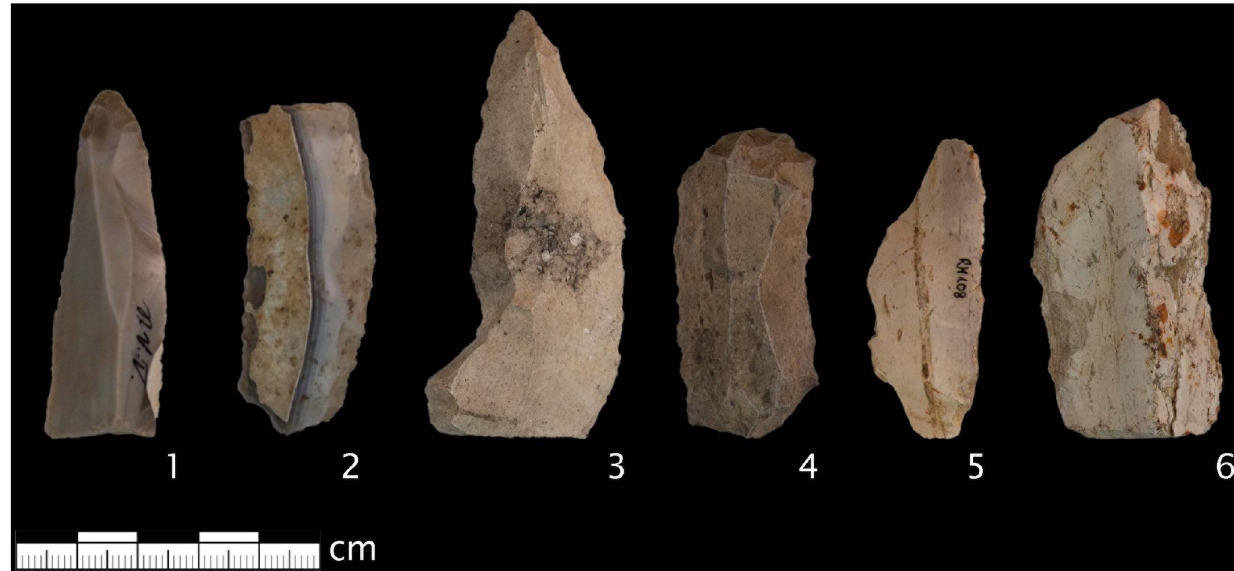
Fig 3. Archaeological samples. 1, 2 Jurassic cherts from Vogelherd, 3, 4 Tertiary cherts from Vogelherd, 5, 6 Tertiary cherts from Randecker Maar. Classifications based on macroscopic criteria. Photos by B. Schu¨rch.